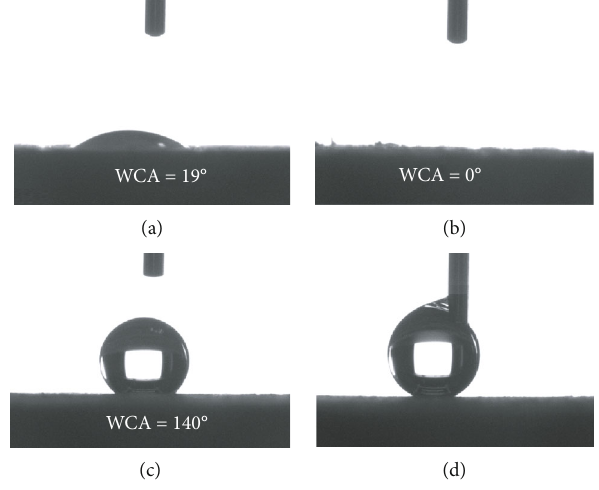
Figure 7: WCA of (a) BT, (b) RGOBT, (c) RGO@SiO